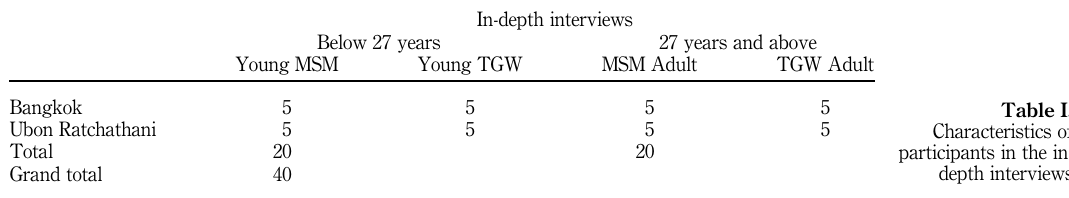
Table I. Characteristics